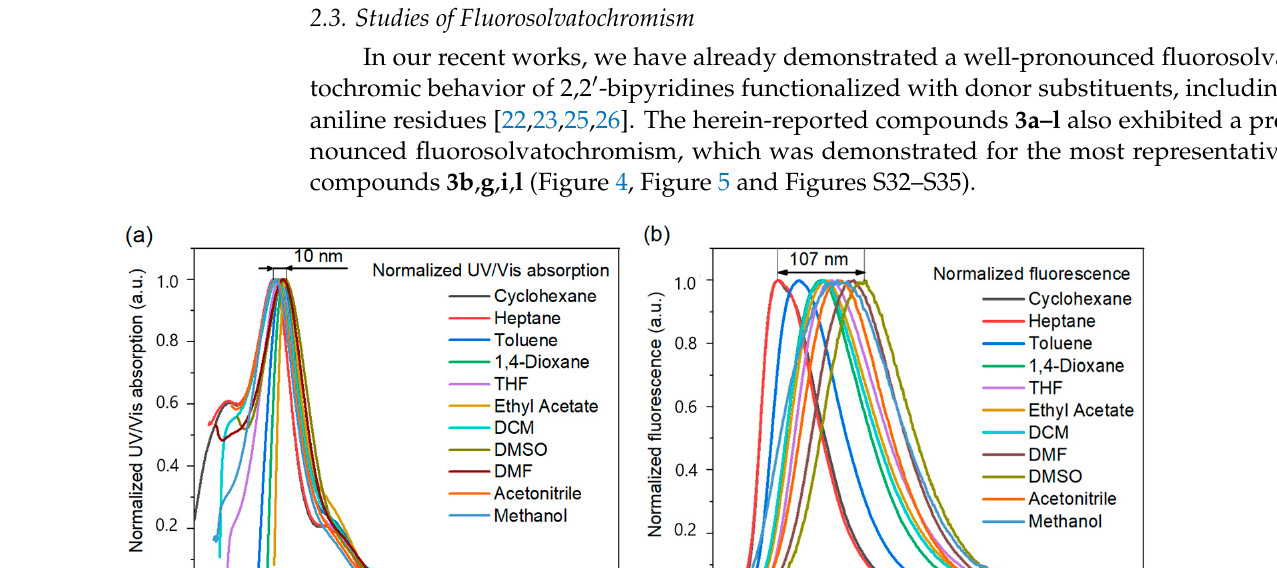
Figure 3. UV/Vis spectra ( a ), molar extinction coefficient, and ( b ) normalized fluorescence ( c ) spectra for 3a–l in THF solutions at room temperature. The concentration of all fluorophores was 10 − 5 M.